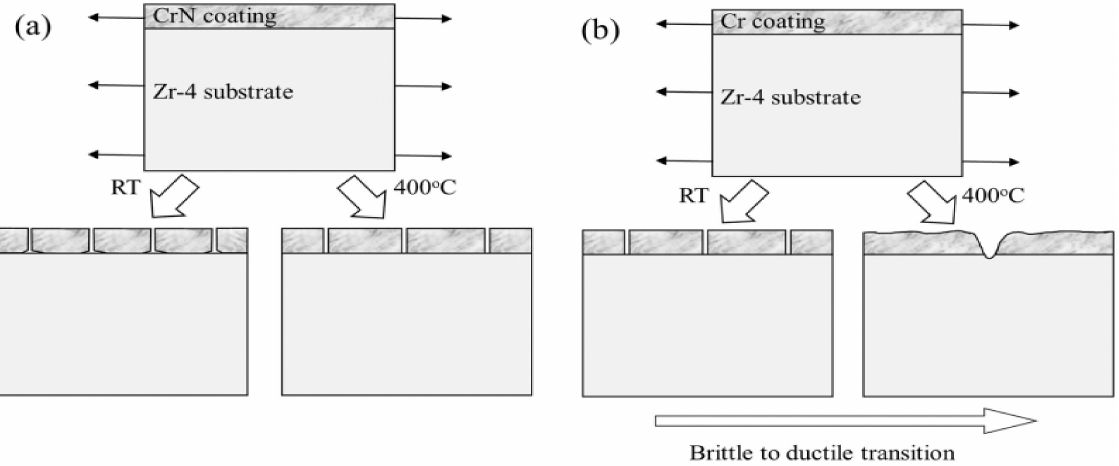
Figure 10. Schematic representation of the fracture response of the coated Zr-4 alloys under tension at room temperature (RT) and 400 ◦ C: ( a ) The CrN-coated specimen and ( b ) the Cr-coated specimen